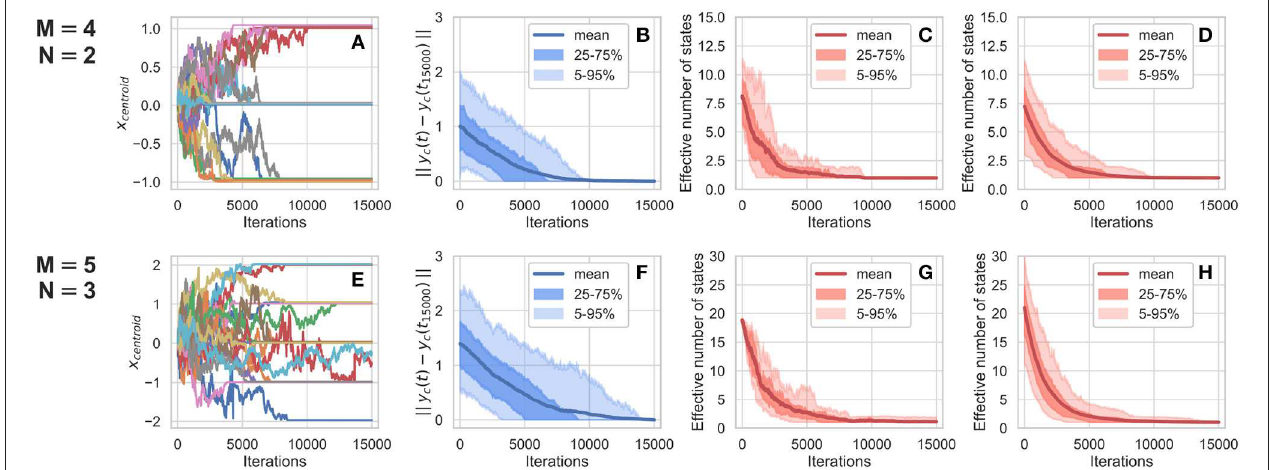
FIGURE 2 | Multiple measures of model convergence. (A) Shows the trajectory of the centroid for 20 runs of the same M coordinate in attitude space, over time, reaching three possible values at t centroid of the same run at t matrix, while (D) shows the effective number of states over time for runs of all M